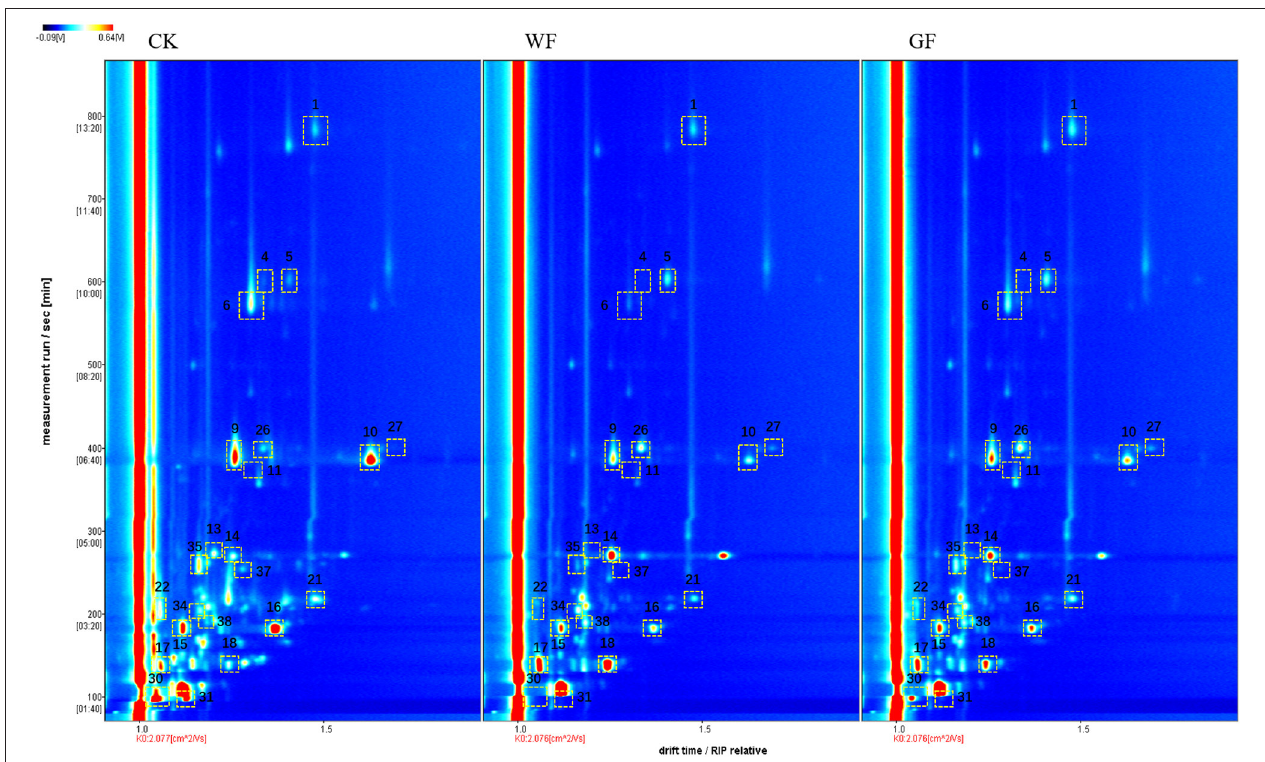
FIGURE 3 | HS-GC–IMS spectra of raw milk from cows fed different diets. (M), Monomer; (D), Dimer. CK, basal diet (without flaxseed); WF, whole flaxseed (dairy cows were fed WF: 1,500 g/d per cow); GF, ground flaxseed (dairy cows were fed GF: 1,500 g/d per cow). 1: Nonanal, 4: Ethyl hexanoate, 5: Octanal, 6: Hexanoic acid (M), 9: 2-Heptanone (M), 10: 2-Heptanone (D), 11: 3-Methylbutyl acetate, 13: Ethyl butanoate, 14: Hexanal, 15: 2-Pentanone (M), 16: 2-Pentanone (D), 17: 2-Butanone (M), 18: 2-Butanone (D), 21: 4-Methyl-2-pentanone (D), 22: Acetoin (M), 26: Heptanal (M), 27: Heptanal (D), 30: Ethanol (M), 31: Ethanol (D), 34: Propyl acetate, 35: 2-Methylpropanoic acid, 37: 2-Hexanol, 38: Pentanal.